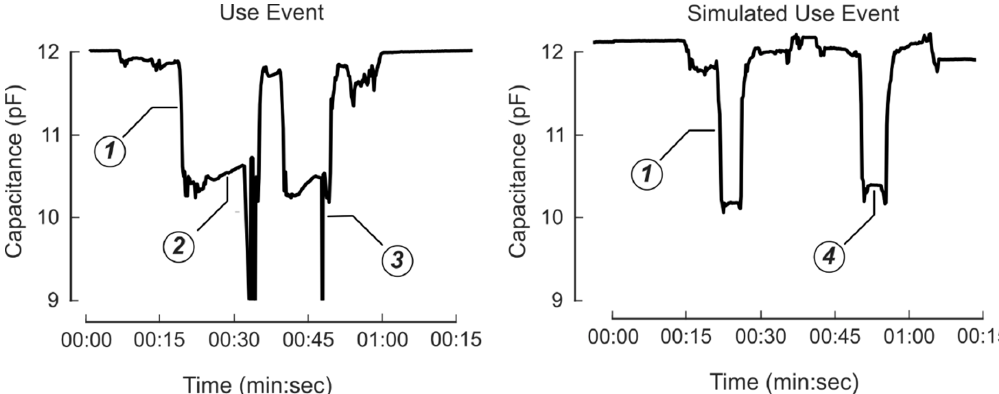
Figure 5. Raw capacitance data of a use event ( left ) and a simulated use ( right ). For both cases, the capacitance dropped as the bottle was flipped ( 1 ) because the fluid flowed out of the bottle body